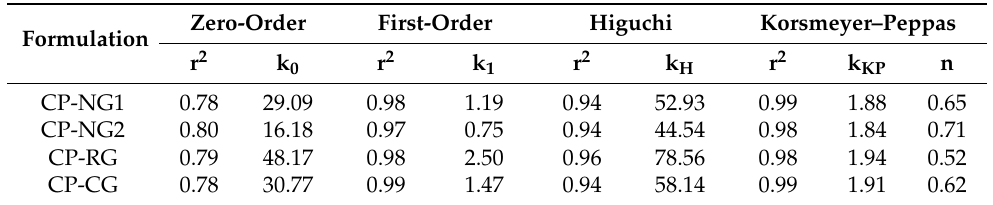
Table 7. Kinetics parameters obtained from fitting the CP release experimental data to various mathematical